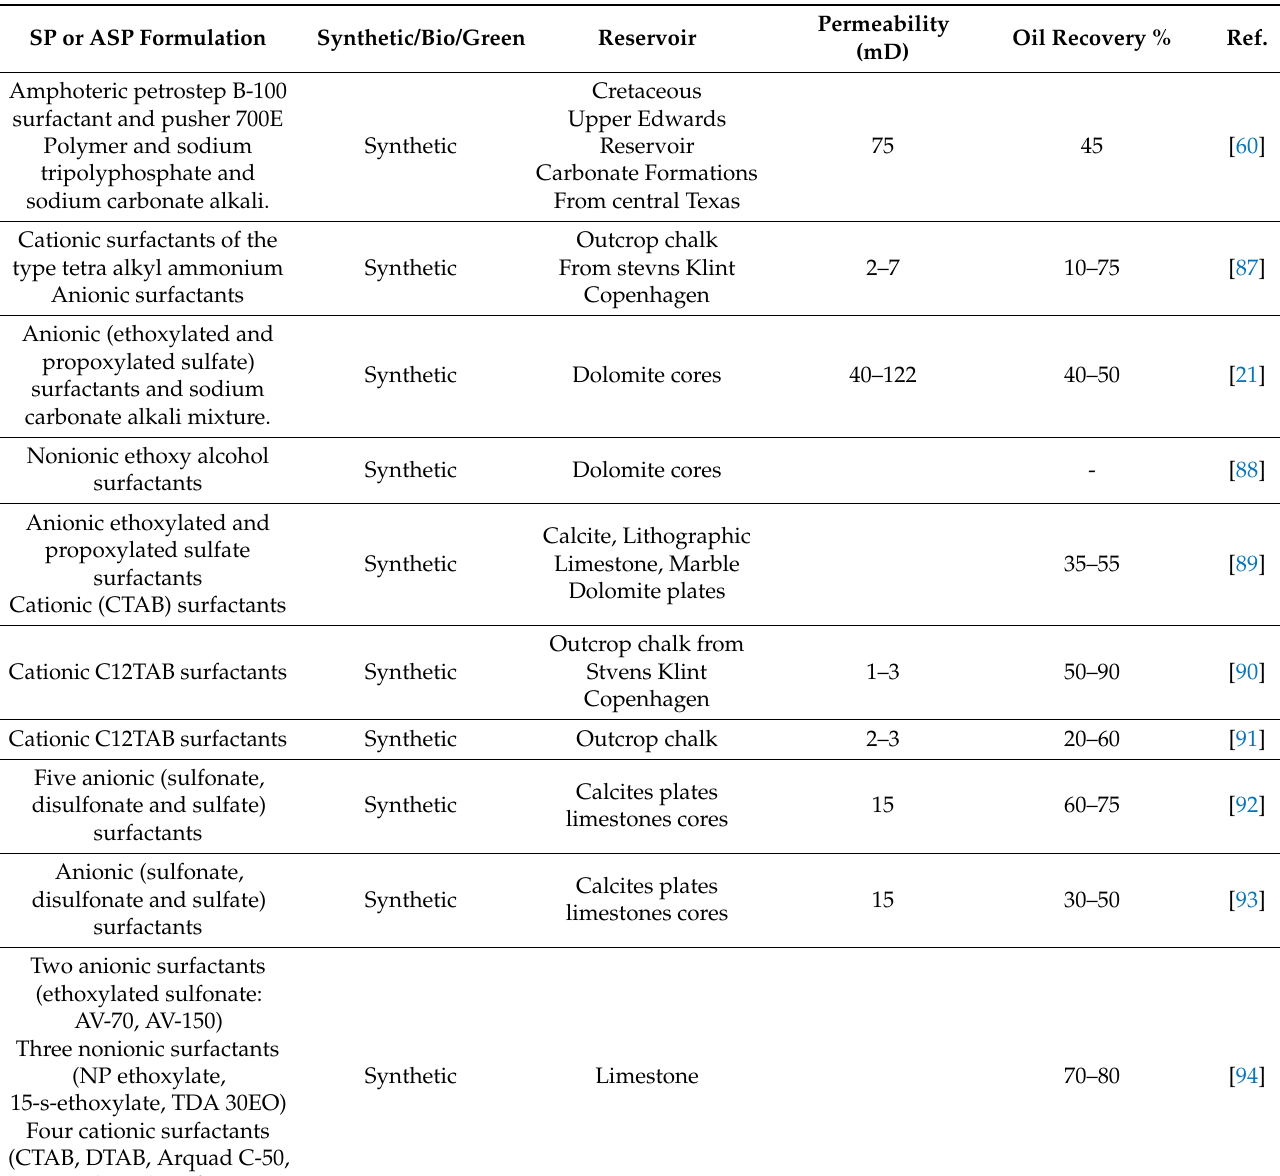
Table A4. Laboratory studies of the SP and ASP method in